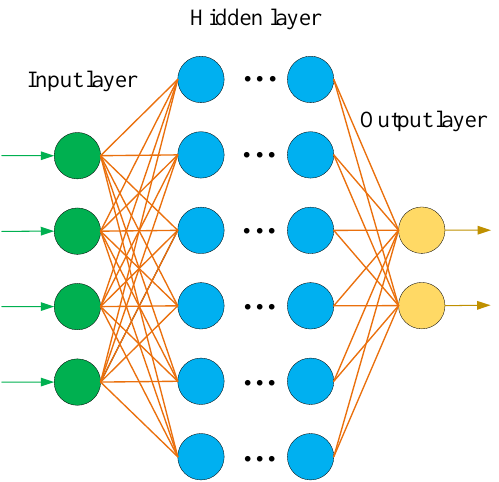
Figure 2. Typical model of a DNN.